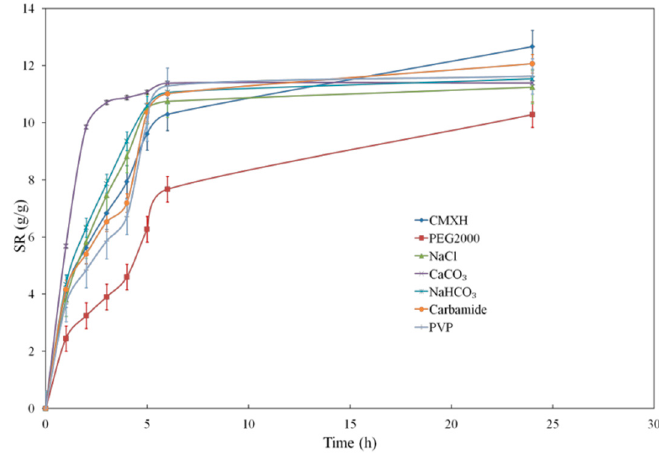
Figure 6. The swelling rates of hydrogels with or without six kinds of pore-forming agents in PBS.